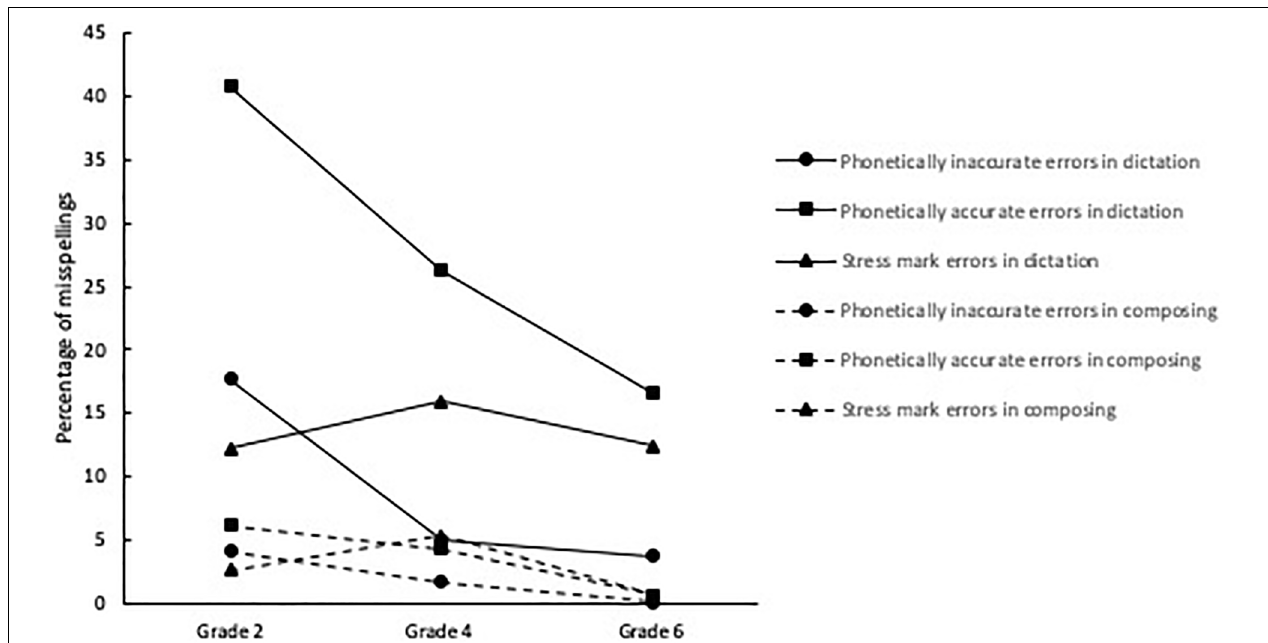
FIGURE 1 | Illustration of the Grade × Error Type X Spelling Task